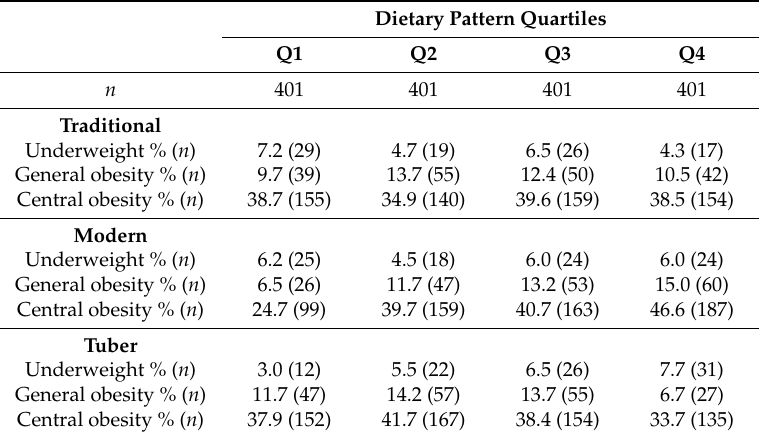
Table 5. Prevalence of underweight, obesity, and central obesity across quartiles of dietary patterns among adults in Southwest China. Dietary Pattern Quartiles Q1 Q2